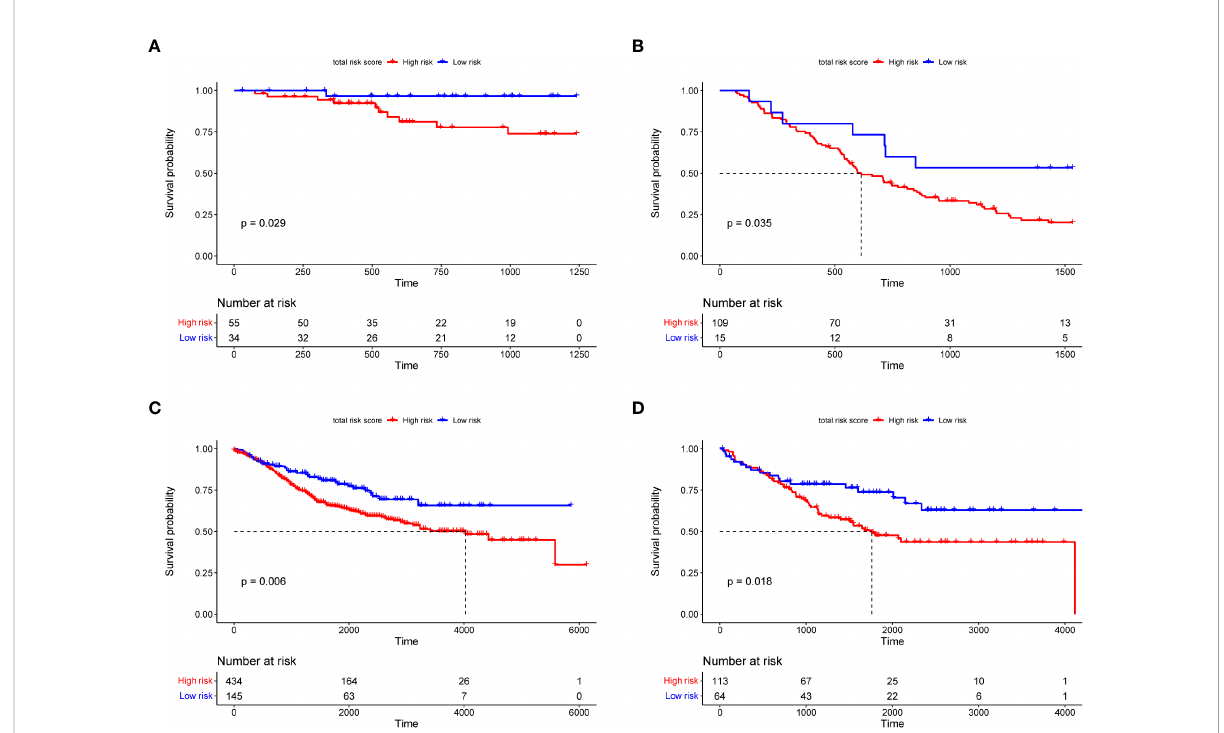
FIGURE 5 The Kaplan – Meier survival curves of overall survival for the RS signature in TCGA (A) , GSE72970 (B) , GSE39582 (C) , and GSE17536 (D) validation datasets. In the KM survival curve, the horizontal coordinate represents the survival time and the vertical coordinate is the survival